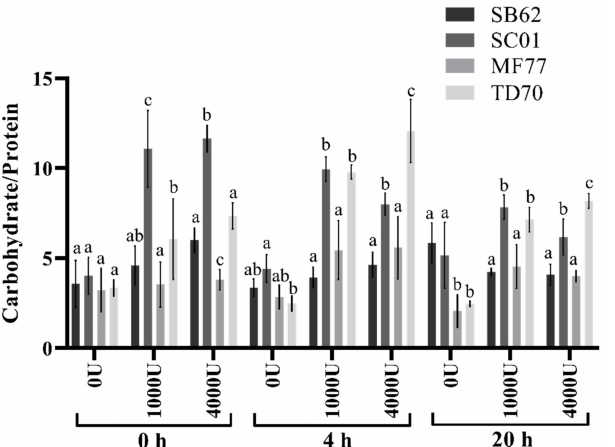
Figure 7. Carbohydrate to protein ratios in samples collected after enzymatic treatment (1000 and 4000 U lyticase/g dry cells weight incubated for 4 and 20 h at 37 ◦ C, with negative controls excluding enzyme and/or incubation time) of SB62, SC01, MF77 and TD70 cells collected after 4 min of ultrasound treatment (50% duty cycle and 80% amplitude). Different letters indicate significant differences ( p < 0.05) between different species within each separate extraction condition as analysed by two-way ANOVA and the Fisher’s LSD